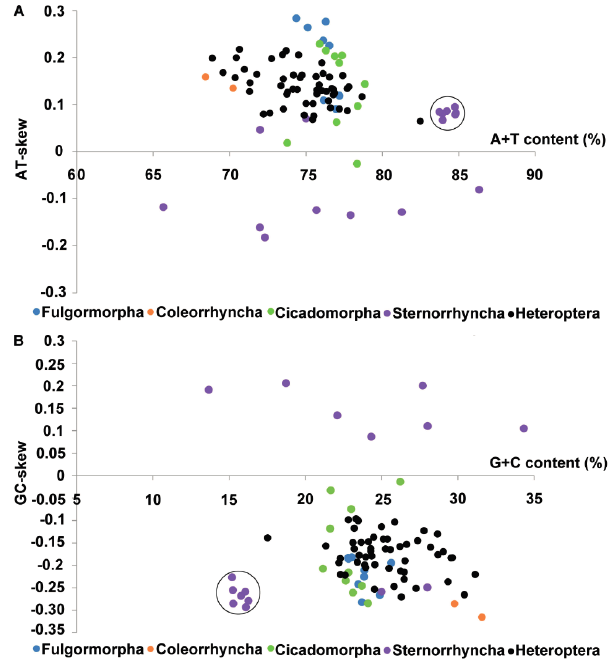
Figure 3. Nucleotide composition across 90 complete hemipteran mitogenomes. ( A ) A +